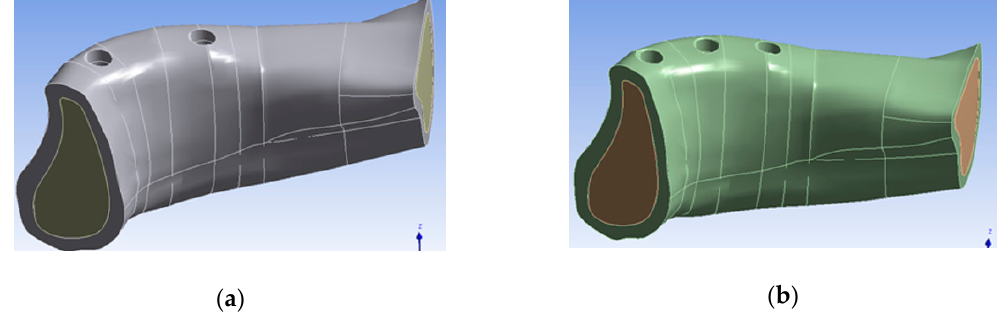
Figure 1. Image of the arrangement of the implants in the two models studied: ( a ) group M1 with two implants; ( b ) group M2 with three implants.